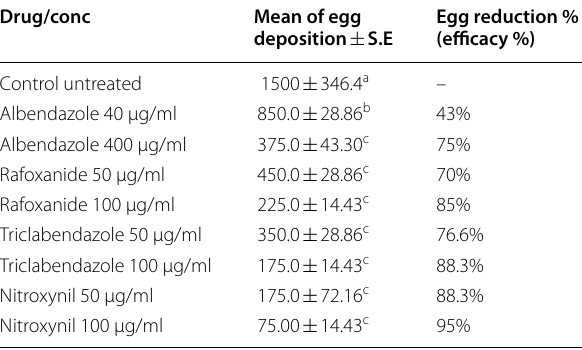
Superscript letters b and c are significant with the control (a). P value was significant at 0.05 ≤